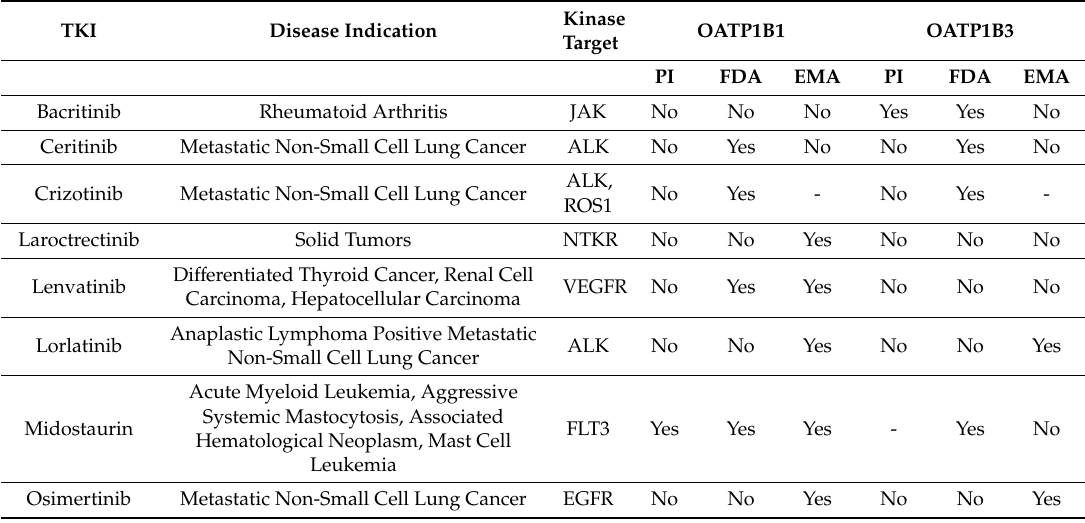
Table 1. Comparison of regulatory guidance documents on OATP1B inhibition by FDA-approved TKIs. TKI Disease Indication